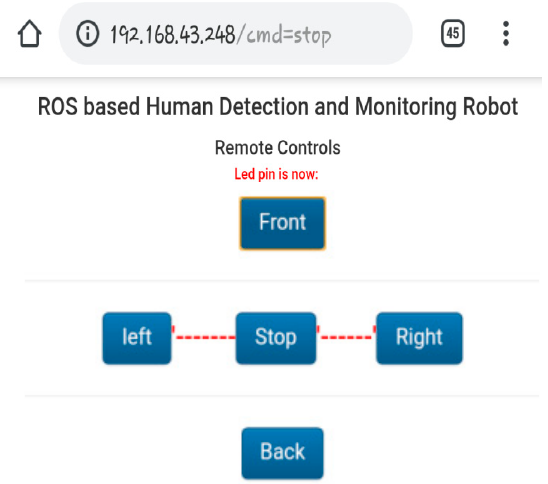
Figure 4. Remote control interface shown in the HTML page.